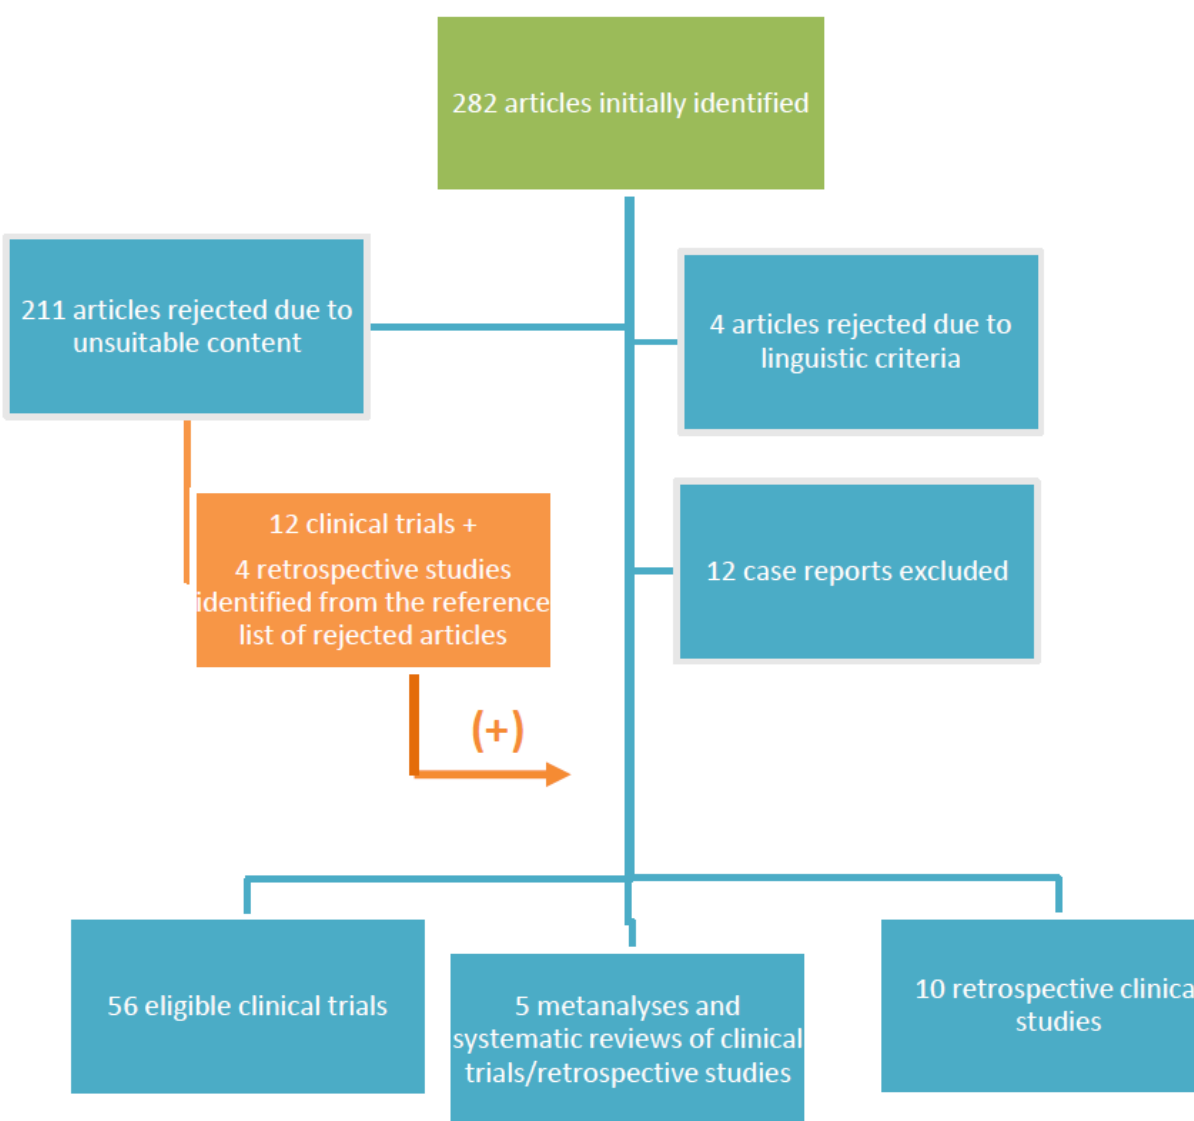
Figure 1. Diagram summarizing the elimination process of the initially identified published papers. There were 4 articles not written in English, 12 case reports and 211 articles with unsuitable content were excluded. Then, 16 eligible articles were recovered from the reference lists of the retrieved articles. Then, 56 clinical trials, 5 metanalyses and systematic reviews and 10 retrospective clinical studies were eventually included in the present review.